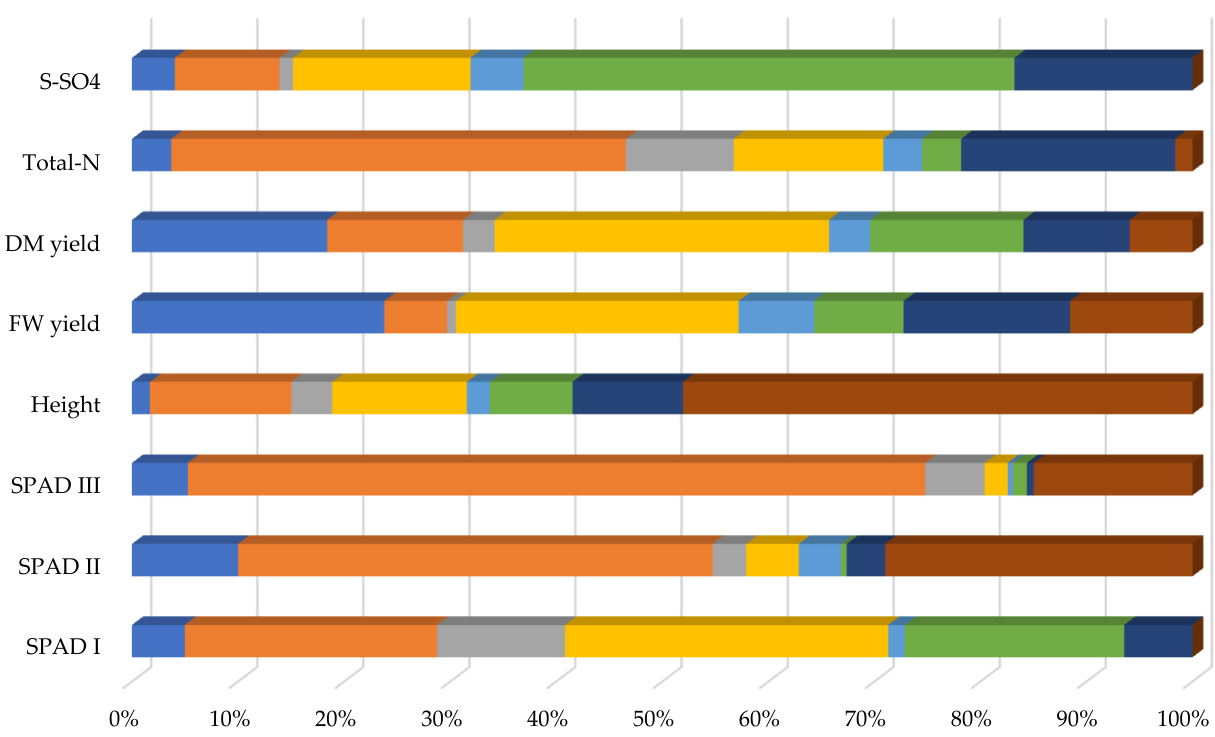
Figure 5. Relatively effect of factors on yield and other parameters of maize— Zea mays L. (in per cent). Key: SPAD I—SPAD in 5th leaf unfolded; SPAD II—SPAD in stem elongation; SPAD III—SPAD in tasselling; FW—fresh weight; DM—dry matter; HA—humic